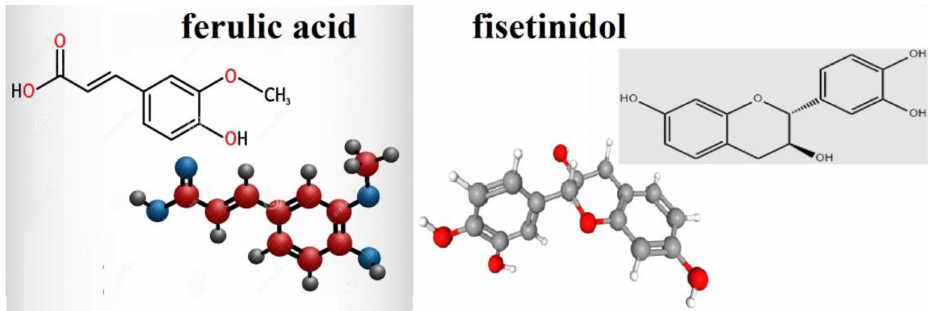
Scheme 1. Ferulic acid and fisetinidol molecular